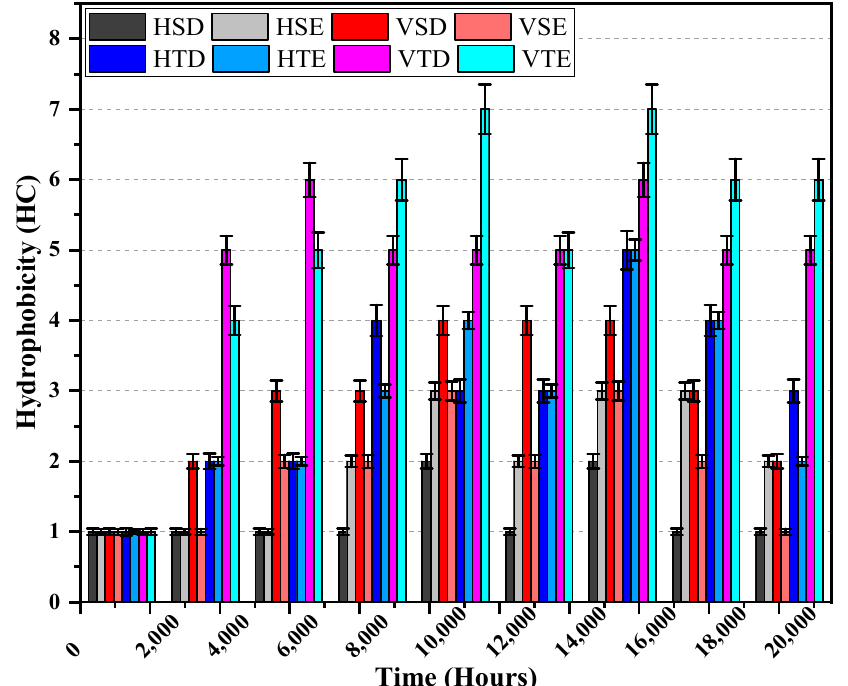
Figure 4. Hydrophobicity classification.